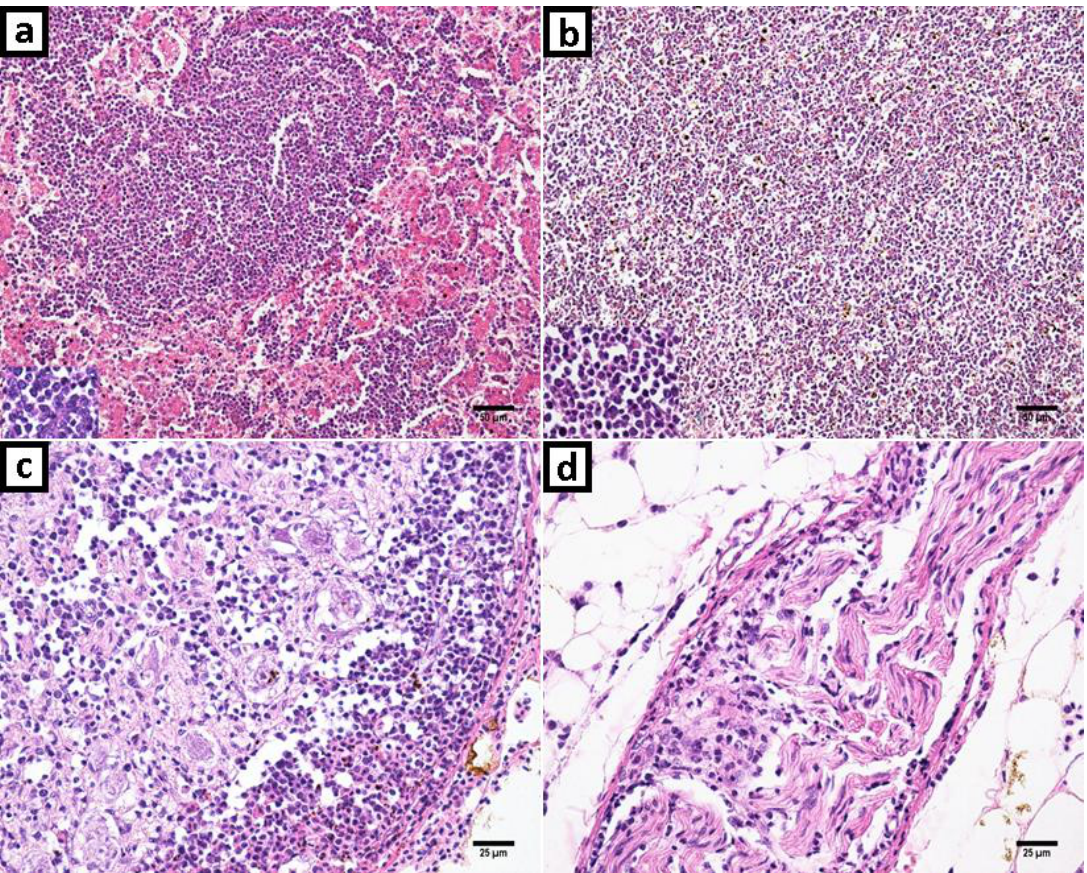
Figure 2. Marek’s disease and reticuloendotheliosis in histopathology with hematoxylin and eosin (H&E) stanning. ( a ) Liver: Proliferation and infiltration of neoplastic small to medium size lymphocytes that replaced liver parenchyma. The neoplastic cells were uniform and small lymphocytes. ( b ) Spleen: Neoplastic lymphoid cells expanding and obliterating histologic structures; and with a highlight in detail of lymphocytes. ( c ) Ganglion: Neoplastic uniform small lymphocytes infiltration and hemorrhage foci. ( d ) Peripheric nerve. Increased cellularity due to small lymphocytes infiltration.